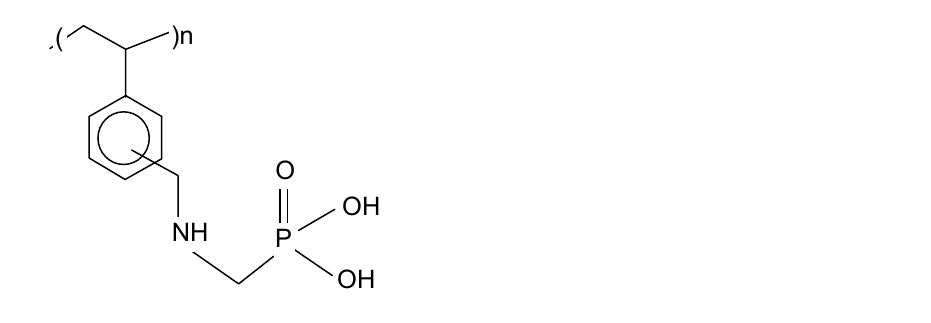
Figure 1. Chemical structure of Purolite S 940 and Purolite S 950. Table 1. Selected physicochemical parameters of Purolite S 940 and Purolite S 950.